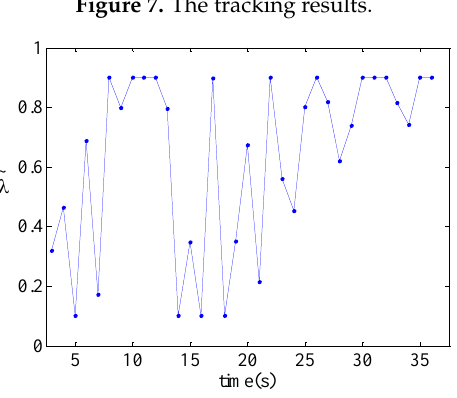
Figure 8 . The estimates of  for target I. Figure 8. The estimates of